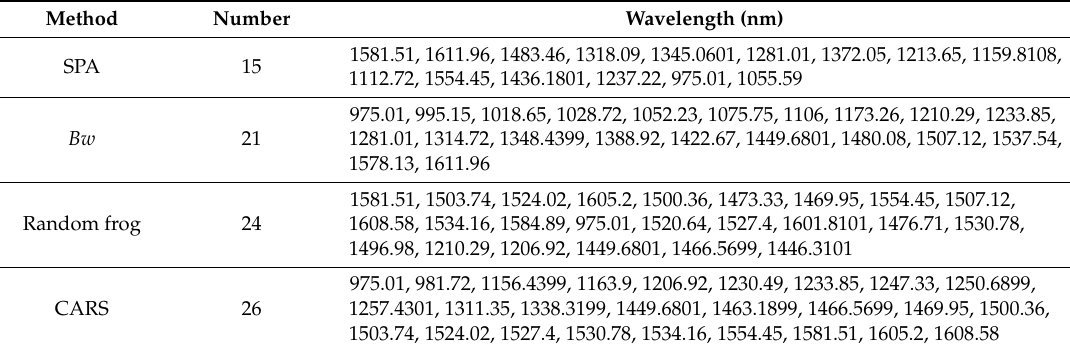
Figure 3. Optimal wavelengths selected by different methods. Table 2. Number of optimal wavelengths and optimal wavelengths selected by SPA, Bw , random frog, and CARS.